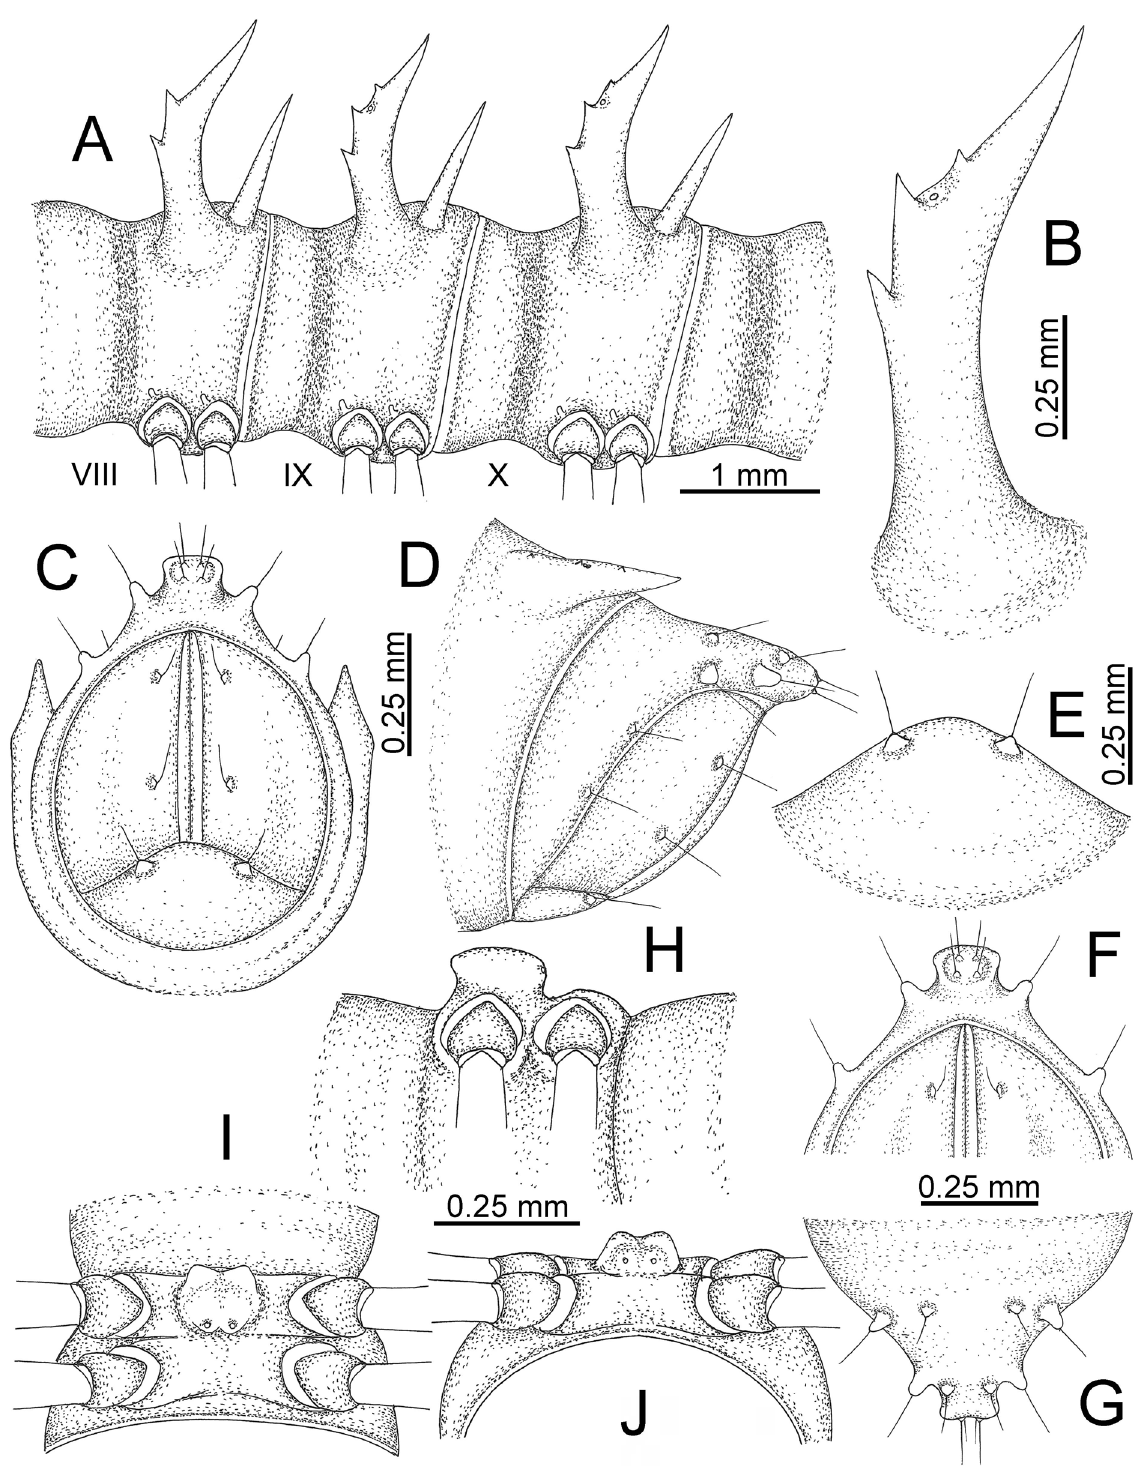
Fig. 24. Nagaxytes spatula Srisonchai, Enghoff & Panha gen. et sp. nov., ♂, paratype (CUMZ- pxDGT00120). A . Body rings 8–10. B . Paraterga of ring 10. C – D . Last ring and telson. E . Hypoproct. F – G . Epiproct. H – J . Sternal lobe between coxae